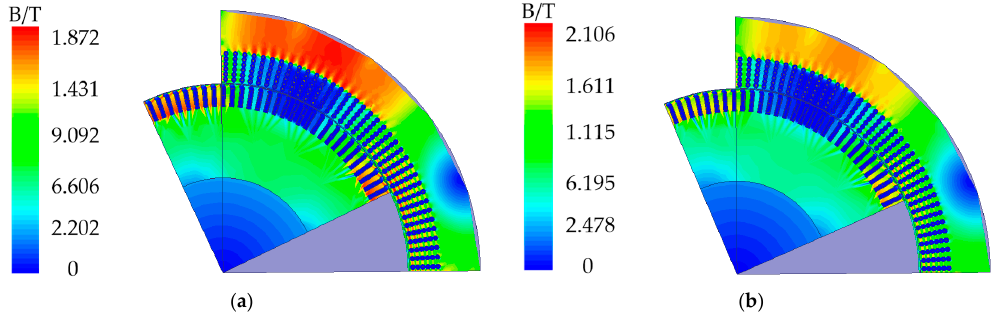
Figure 8. The distributions of the magnetic field for the generator in normal operation and the three phase short-circuit loss of excitation in the subsynchronous operation state, when s is 0.08: ( a ) Normal operation; ( b ) three phase short circuit loss of excitation operation.